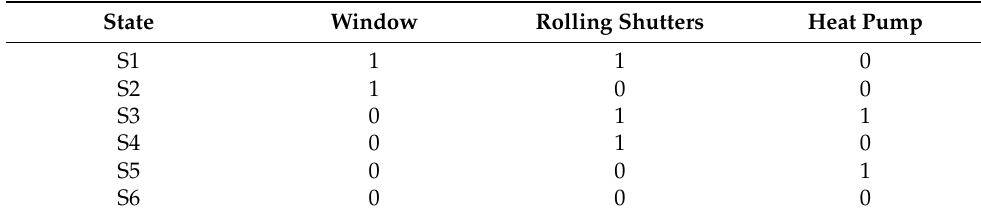
Table 8. Split range operating modes (thermal control, initial control system).